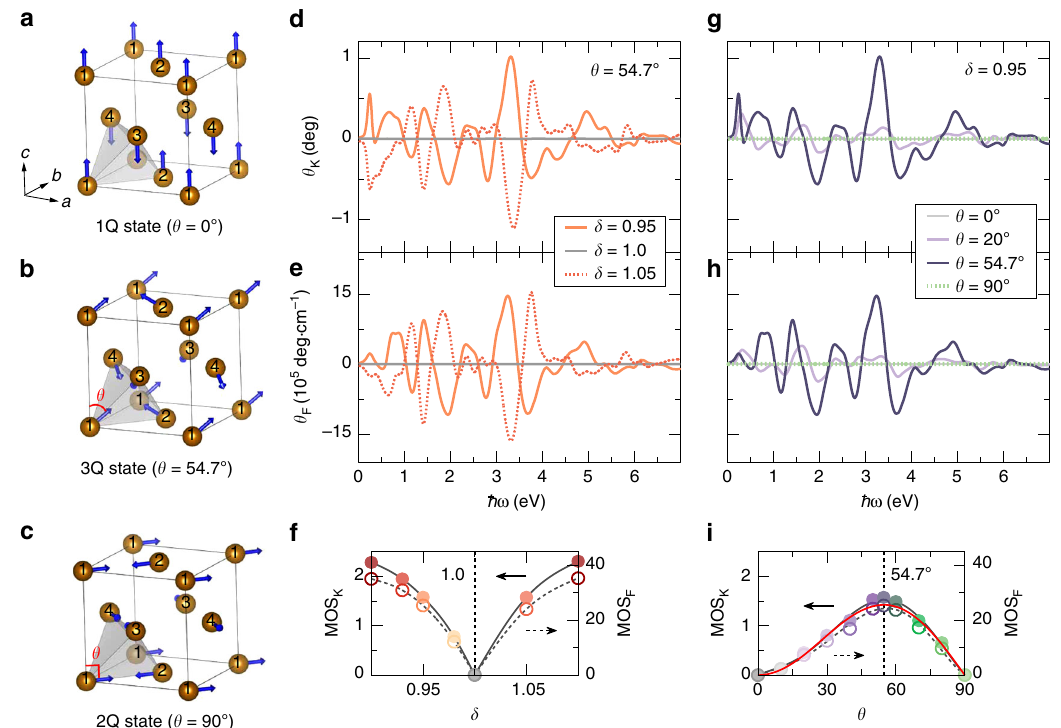
Fig. 3 Topological magneto-optical effect in γ -Fe x Mn 1 − x . a – c 1 Q , 3 Q , and 2 Q spin textures of γ -Fe x Mn 1 − x . Blue arrows indicate the local spin moments. Numbers 1 – 4 label four magnetic sublattices (Fe or Mn site). The spin texture is characterized by the polar angle θ that measures the rotation of spins 1 and 2 within the (1 (cid:2) 10) plane and the rotation of spins 3 and 4 within the (110) plane. d , e The Kerr and Faraday rotation angles of γ -Fe 0.5 Mn 0.5 (3 Q state) under various strain. f The magneto-optical strength (MOS) of Kerr and Faraday effects in γ -Fe 0.5 Mn 0.5 (3 Q state) as a function of strain. g , h The Kerr and Faraday rotation angles of γ -Fe x Mn 1 − x with different spin textures. i The MOS of Kerr and Faraday effects in γ -Fe x Mn 1 − x as a function of θ . The solid red line denotes the angular dependence of scalar spin chirality, given by χ ijk ð θ Þ / cos θ sin 2 θ . Spin – orbit coupling is not included in d – i